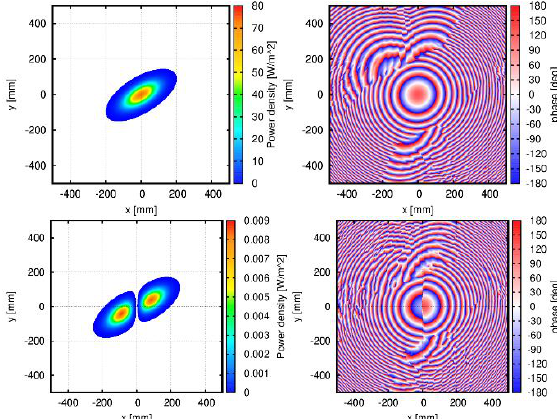
Fig. 7. Field of the beam U1 after the mirror M4